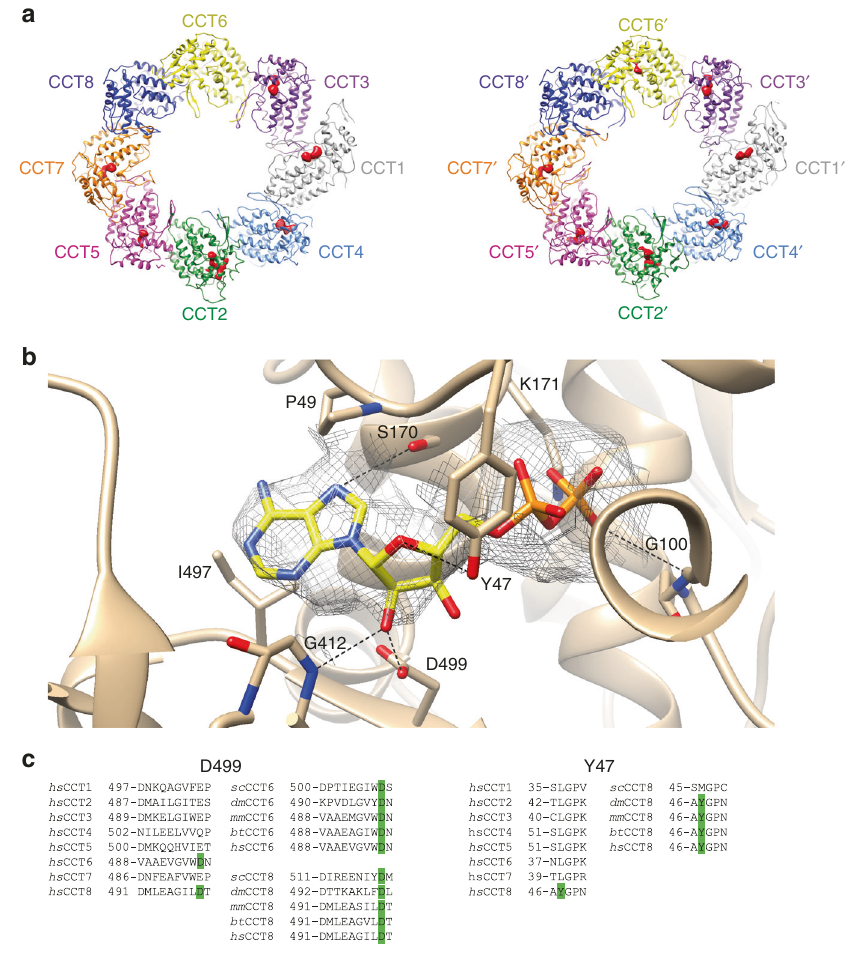
Fig. 6 Nucleotide-binding state of the CCT – mLST8 complex. a Distribution of nucleotide density in the difference map between the yeast AMP – PNP CCT and the human mLST8 – CCT reconstructions. Since all the nucleotide-binding sites of the AMP – PNP CCT reconstruction host a nucleotide, density differences (highlighted in red) indicate unoccupied nucleotide-binding pockets in mLST8 – CCT complex, and lack of red density indicates the presence of nucleotide in CCT8, CCT8 ′ , CCT6 and partially in CCT6 ′ . b ADP binding site in CCT8. The protein ribbon diagram is shown in tan with residues in close contact with the ADP molecule highlighted as sticks. The ADP is also represented in sticks with carbon in yellow, oxygen in red, nitrogen in blue and phosphorous in orange. Hydrogen bonds are depicted as dashed lines. The map contour level is set at 2.5. The fi gure was produced with Chimera. c Alignments of the CCT amino-acid sequences adjacent to D499 and Y49 of CCT8 comparing the eight human CCT subunits and CCT6 and CCT8 from different species. Residues identical to D499 of CCT6 and CCT8 and Y49 of CCT8 are highlighted in green. hs Homo sapiens, bt Bos taurus, mm Mus musculus, dm Drosophila melanogaster, sc Saccharomyces